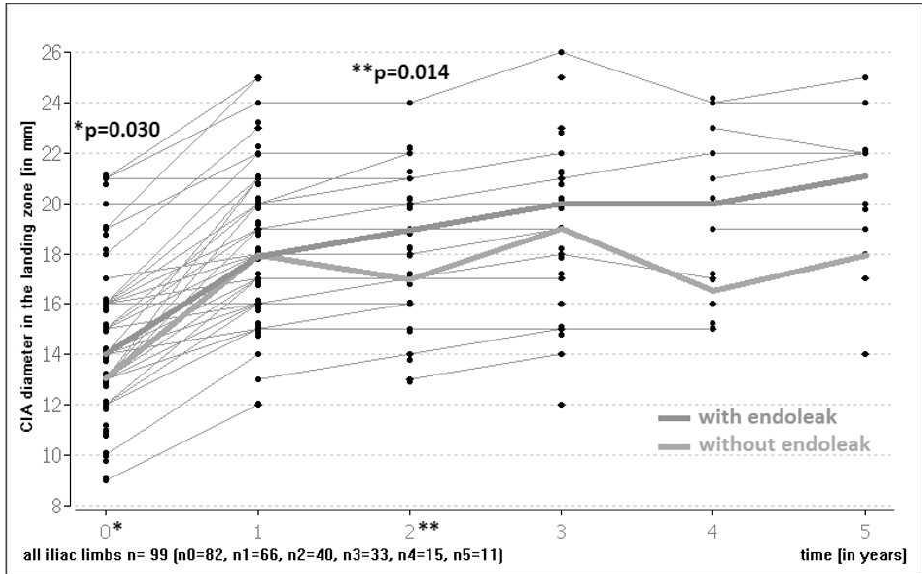
Figure 3. Common iliac artery (CIA) diameter in landing zone over time with endoleak vs. without endoleak. (*: baseline; **: 2 year follow-up). endoleak. (*: baseline; **: 2 year